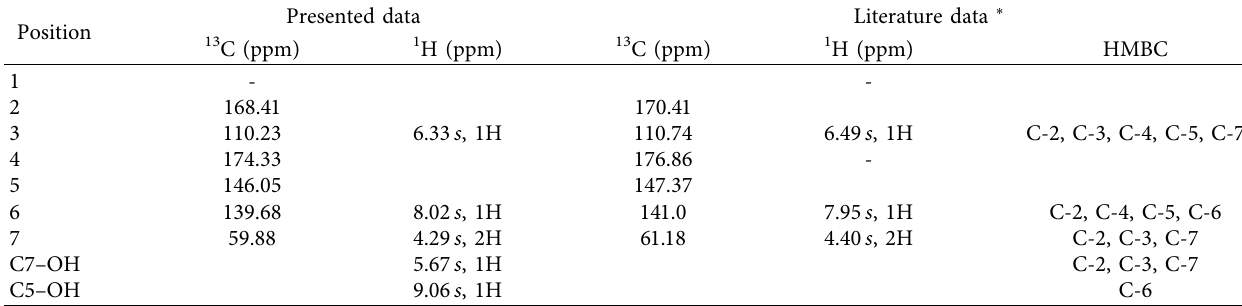
Table 3: 1 H, 13 C NMR data of kojic acid (in DMSO- d 125MHz (C).